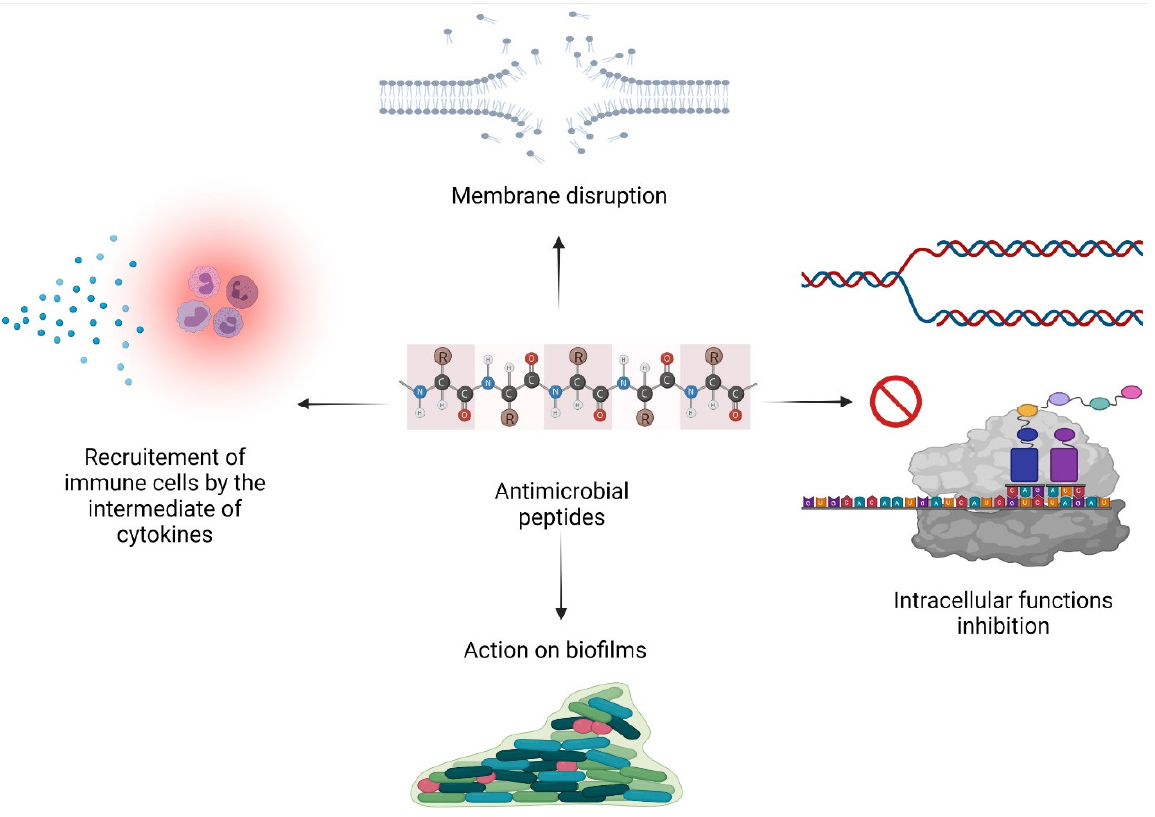
Figure 1. Mechanisms of action of antimicrobial peptides